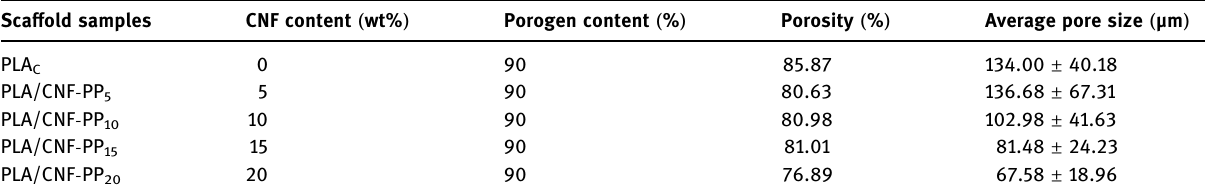
Table 1: Composition, porosity, and average pore size of CNFs - reinforced PLA - based sca ff olds Sca ff old